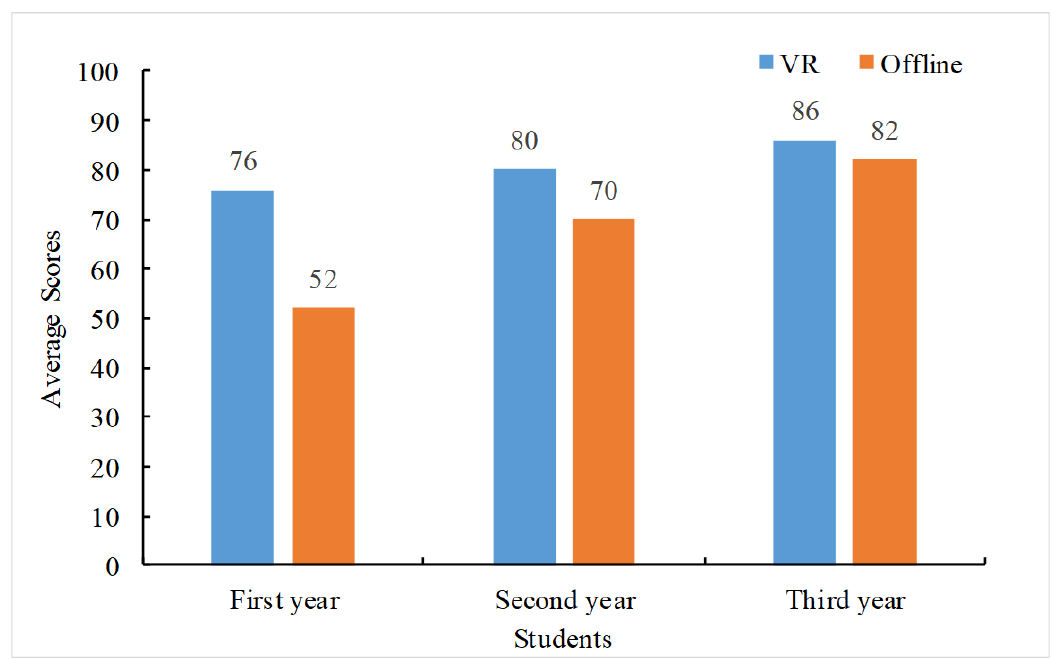
Figure 13. The average score of each control group.